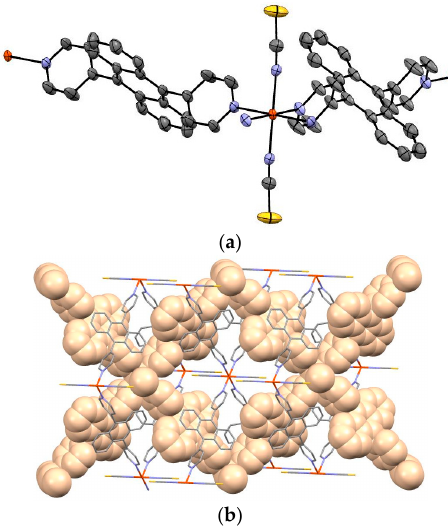
Figure 3. The ORTEP drawing ( a ) and the packing view ( b ) of complex 1 .